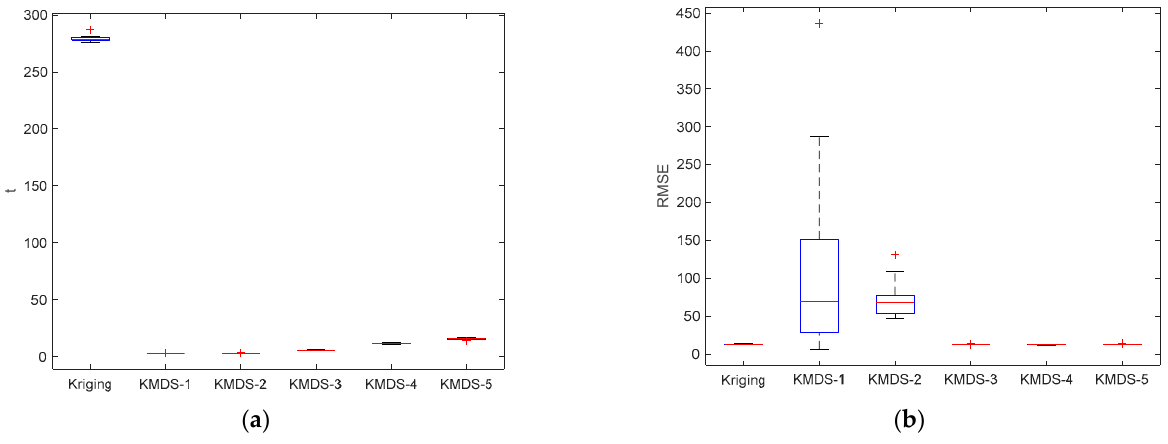
Figure 2. ( a ) Modeling time for 220 points. ( b ) Modeling error (RMSE) for 220 points.